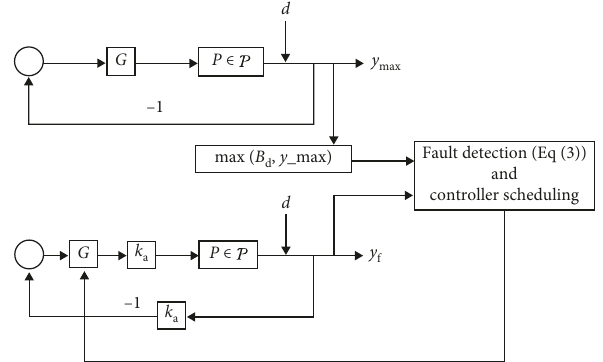
Figure 1: Proposed integrated fault detection and control.